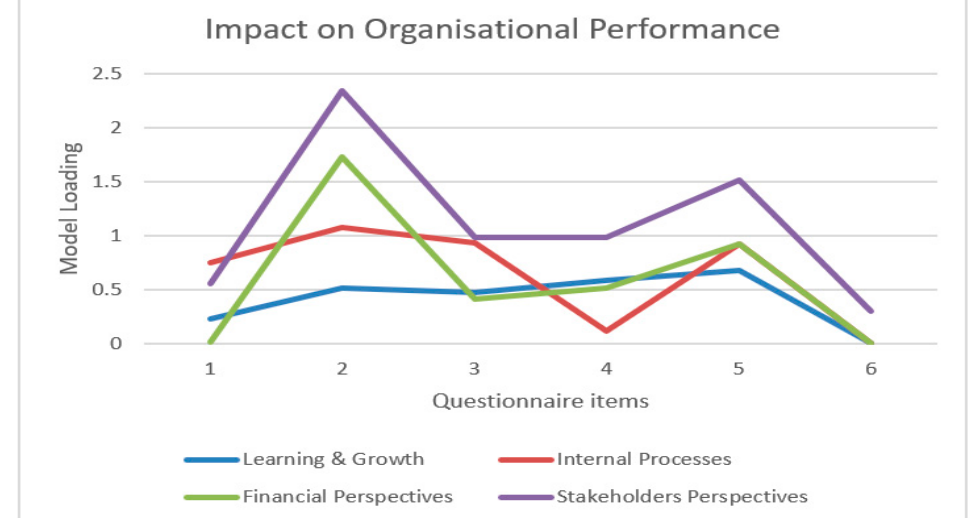
Figure 2. Areas of concern regarding the impact on Organisational Performance (OP).